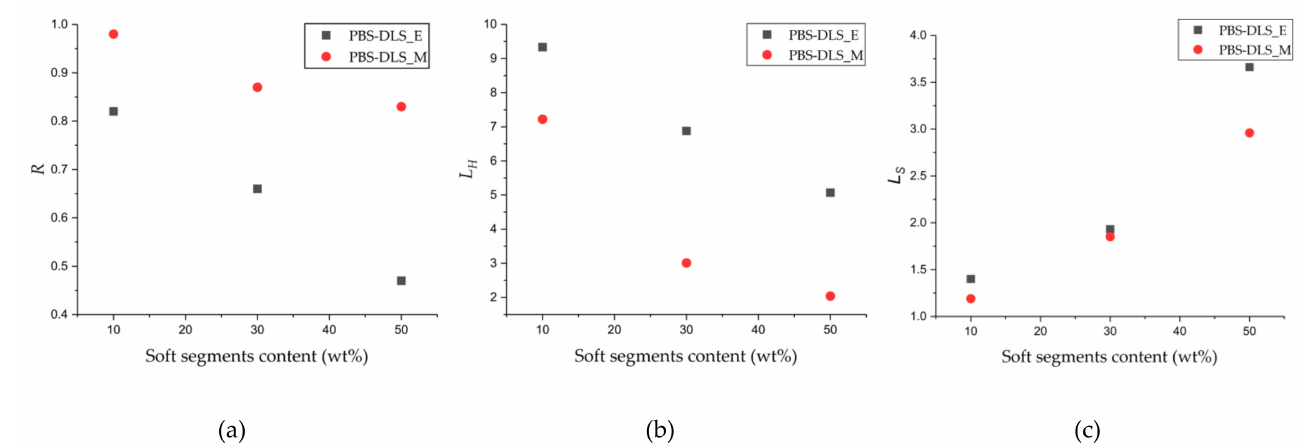
Figure 5. ( a ) Degree of randomness (R), average sequence length of ( b ) hard (L H ) and ( c ) soft (L S ) segments as a function of soft segment content in PBS-DLS_E and PBS-DLS_M